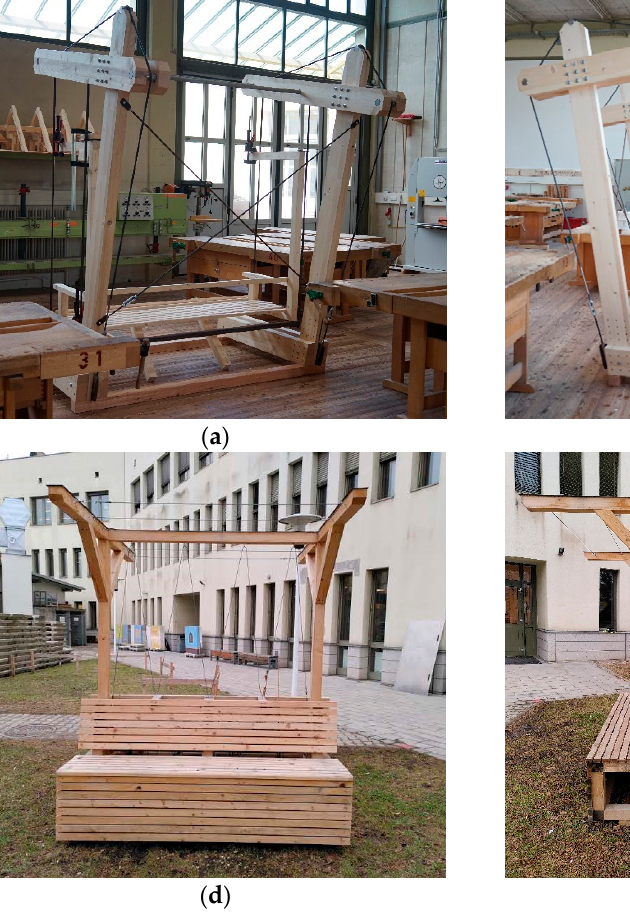
Figure 5. Open-space greening systems built by students at CSBT in Vienna: ( a – c ) hanging chair “Green Trio”; ( d – f ) pergola “T-Bench”.